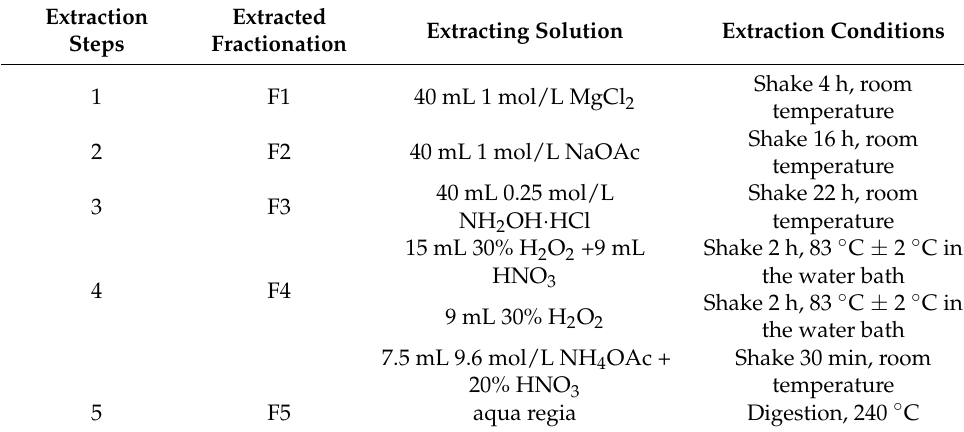
Table 2. The modified Tessier’s sequential extraction